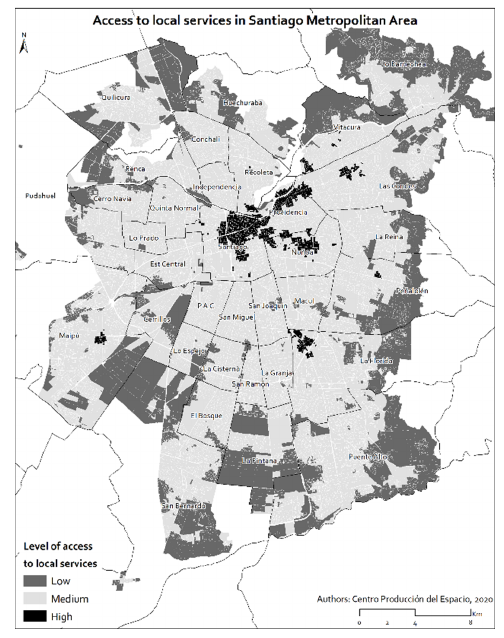
Figure 1. Access to Local Services in the Santiago Metropolitan Area. Source: authors. Land 2020 , 9 , x FOR PEER REVIEW